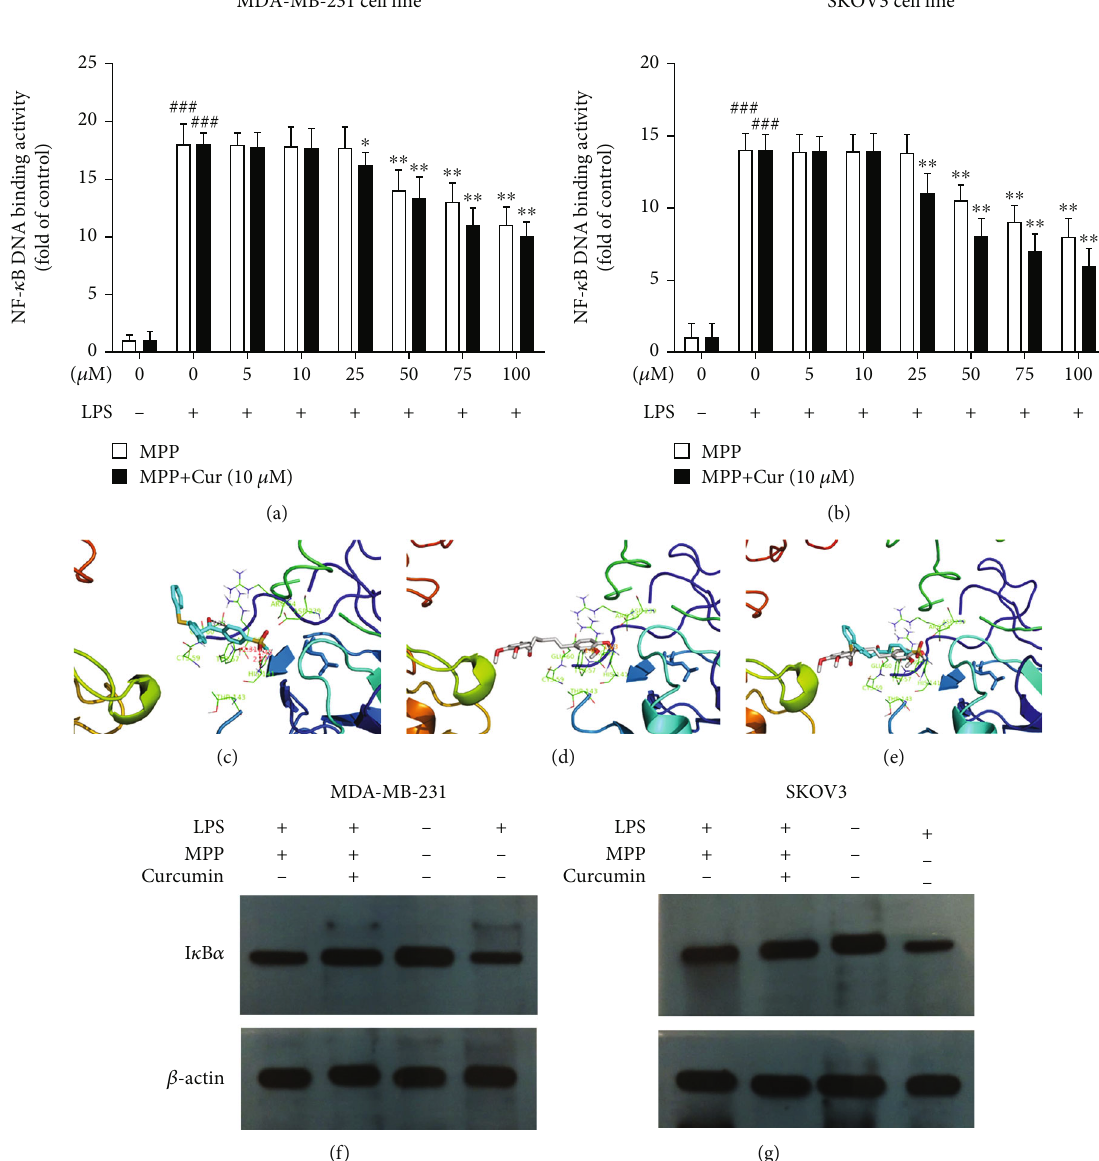
Figure 3: The DNA-binding activity of NF- κ B in LPS-stimulated (a) MDA-MB-231 cells and (b) SKOV3 cells, in response to various concentrations of MPP with or without 10 μ M curcumin. The error bar represents the standard deviation (SD) of mean from three separate experiments. ### P < 0 : 001 compared with untreated unstimulated control cells; ∗ P < 0 : 05 and ∗∗ P < 0 : 01 compared with LPS- stimulated untreated cells. The results of docking experiment, representing NF- κ B1 active site containing (c) MPP and (d) curcumin. (e) Superimposition of MPP (cyan) on curcumin (gray) in NF- κ B1 active site. The levels of I κ B in (f) MDA-MB-231 cells and (g) SKOV3 cells, normalized to β -actin levels, performed by Western